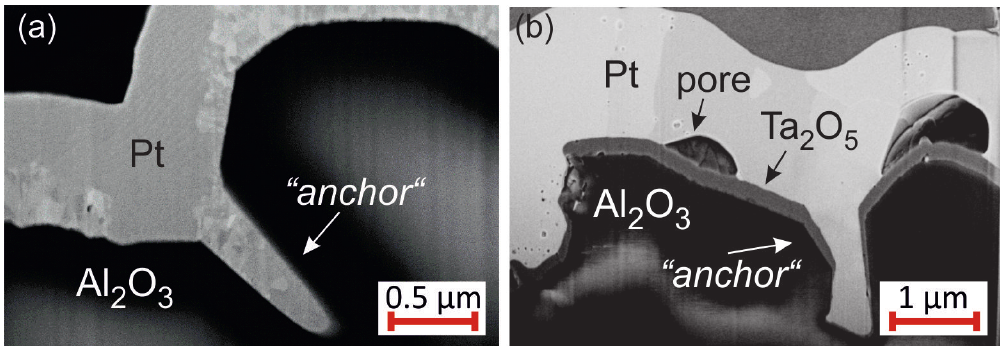
Figure 15. Example of anchor structures, which fix the Pt ∗ film to the Al 2 O 3 substrate. ( a ) Pt seed layer, sample annealed at 400 ◦ C in air and ( b ) Ta seed layer, sample annealed at 800 ◦ C in